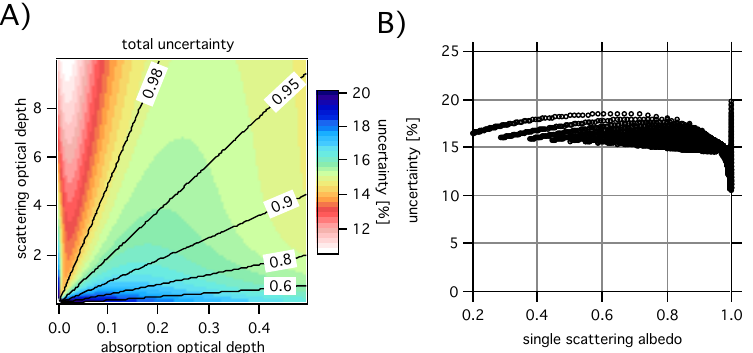
Figure 13. (a) Total uncertainty in the relative optical depth calculated by propagation of uncertainties by model and experimental calibration. (b) Total uncertainties versus particle single-scattering